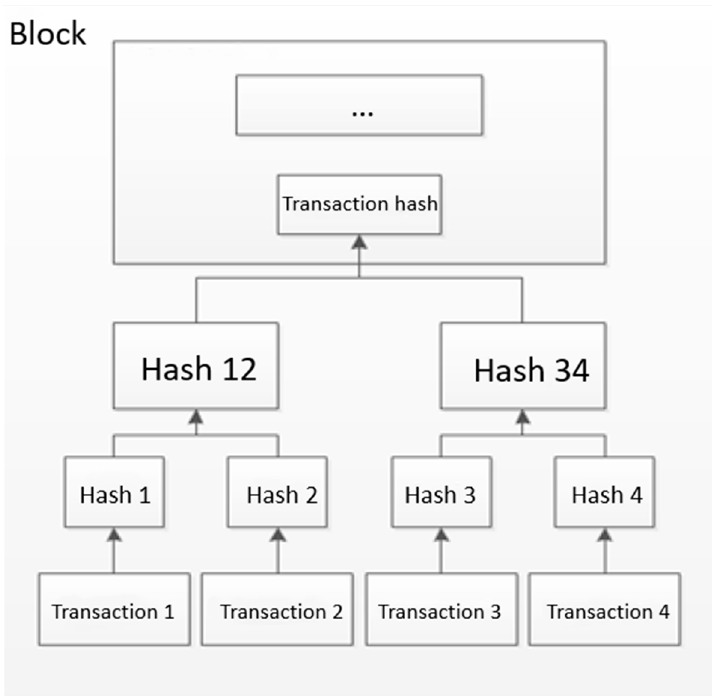
Figure 1. The scheme of obtaining a hash of transactions in cryptocurrencies. Source: https://www.blockchain.com.